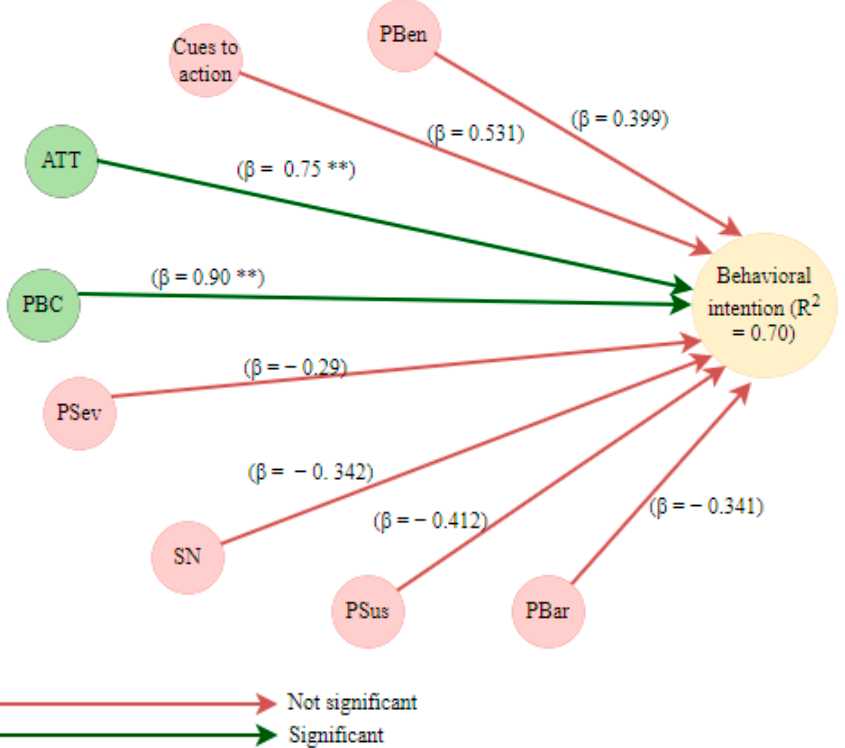
Figure 7. Predicting Behavioral intention based on the integrated TPB and HBM theory (Model 3). R 2 = Nagelkerke R square, * p < 0.05, ** p < 0.001. PBen = Perceived benefits; ATT = Attitude; PBC = Perceived behavioral control; PSev = Perceived severity; SN = Subjective norms; PSus = Perceived susceptibility and PBar = Perceived barriers.